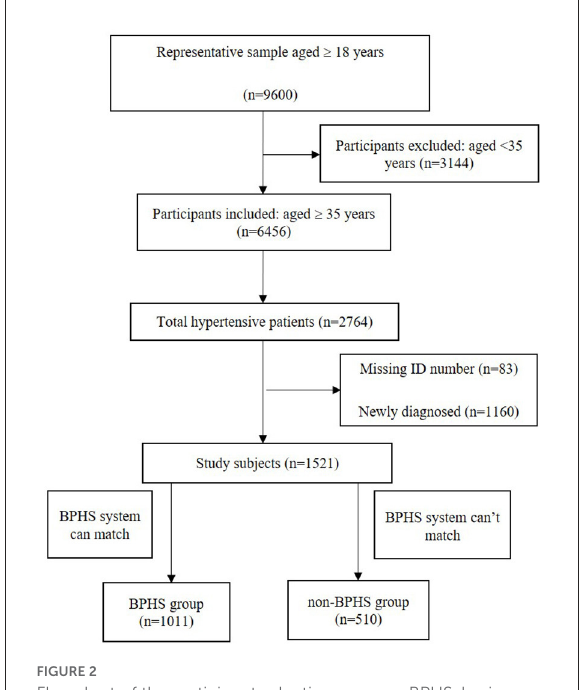
FIGURE2 Flowchart of the participant selection process. BPHS, basic public health